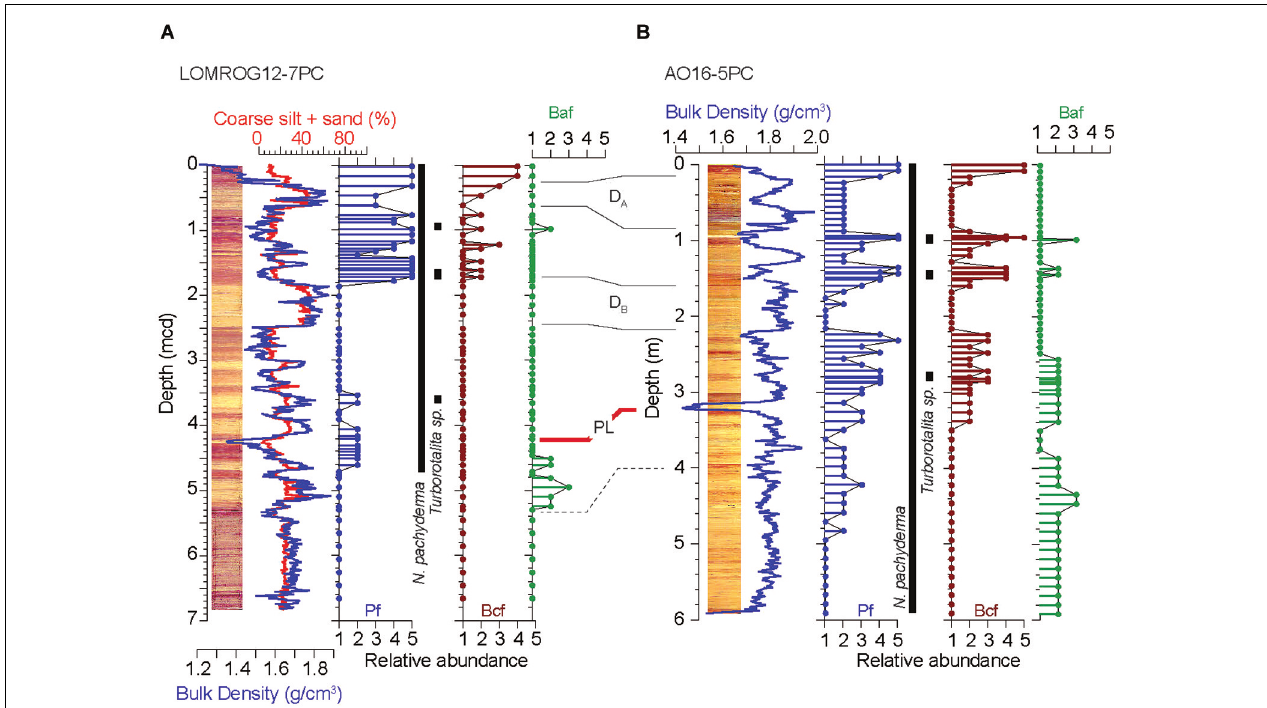
FIGURE 6 | Relative foraminifer abundance ( > 125 µ m) and occurrences of Turborotalita (63–125 µ m) in (A) LOMROG12-7PC and (B) AO16-5PC. Pf, planktic foraminifera; Bcf, benthic calcareous foraminifera; Baf, benthic agglutinated foraminifera. Numbers on the relative abundance scales correspond to: 5, abundant; 4, common; 3, few; 2, rare; 1, barren. The close association of bulk density and the coarse silt + sand content is shown for LOMROG12-7PC. Correlative stratigraphic features between these two cores are taken from Figure 5 . Occurrence zone of N. pachyderma and Turborotalita spp. are shown alongside each core.